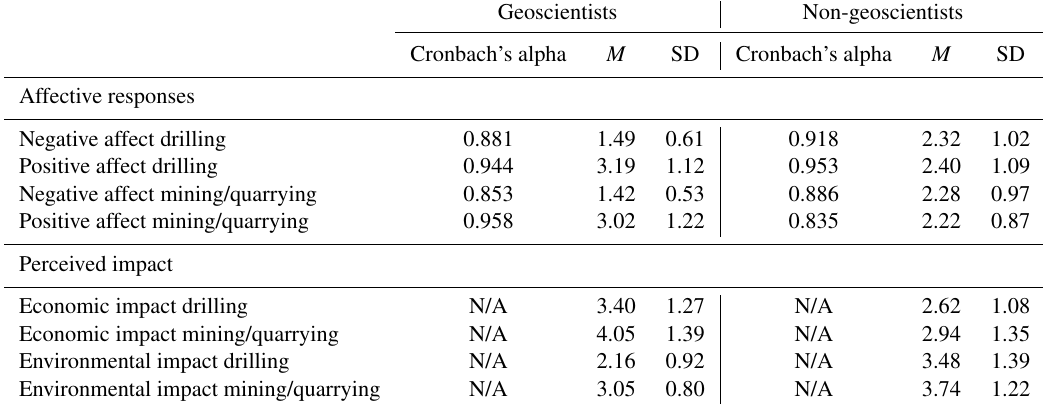
Table 2. Reliability, mean (M), and standard deviations (SD) of scales of affective responses and perceived